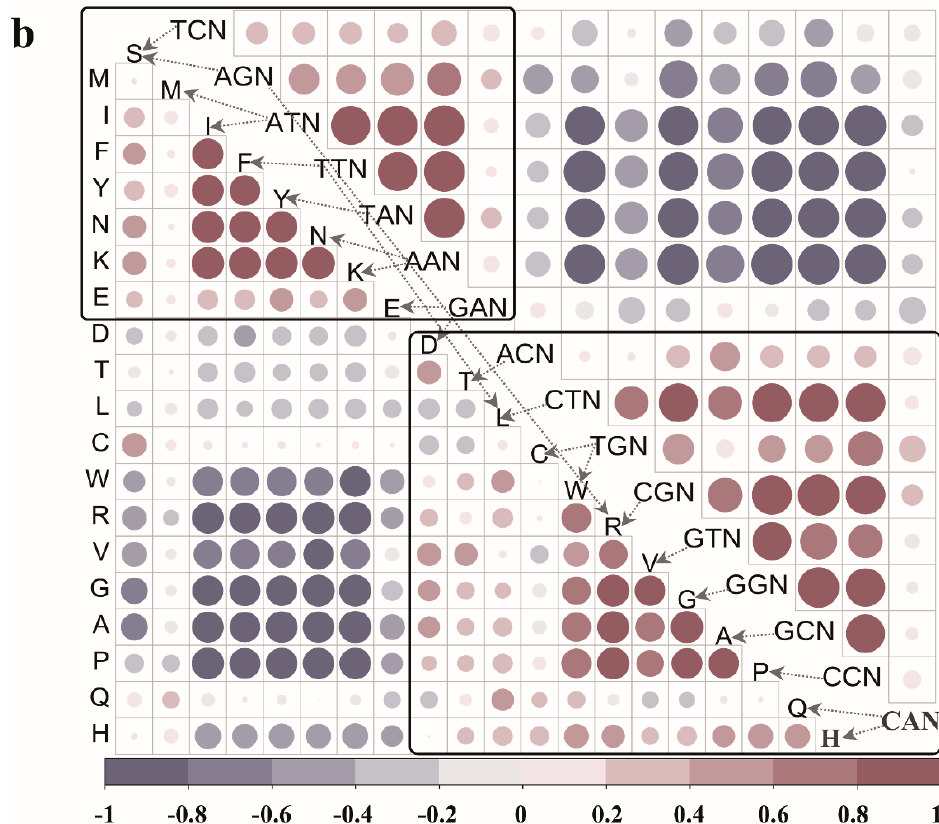
Figure 4. Correlation analysis of amino acids/genetic codons. ( a ) Correlation analysis of codon usage (excluding stop codons) in all species. Note: N represents any base. ( b ) Correlation analysis of amino acid usage (bottom left) and codon usage with the same first two bases (top right) in all species. Note: Single-letter abbreviations denote amino acids. Arrows indicate the correspondence between codons and amino acids. The figures were constructed using the corrplot R